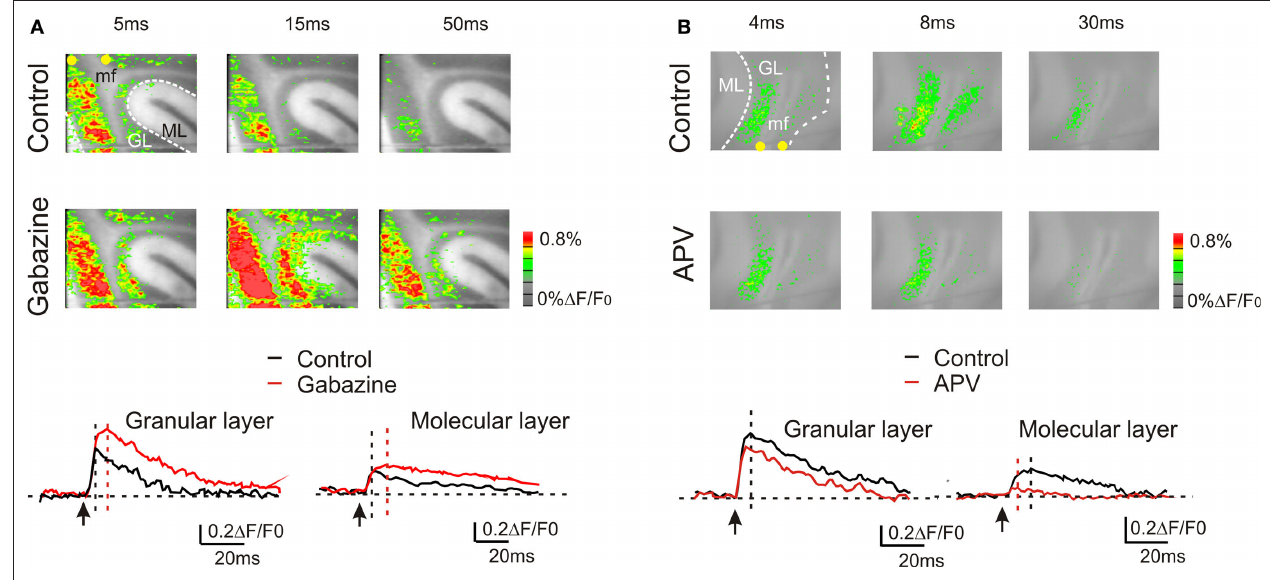
FiGure  | GABA-A and NMDA receptor-dependent regulation of transmission along the mossy fiber pathway. (A) The effect of the GABA-A receptor blocker 10-μM gabazine in response to a single pulse in the white matter. Gabazine enhanced the granular layer response and facilitated transmission toward the molecular layer. The traces show the time course of the